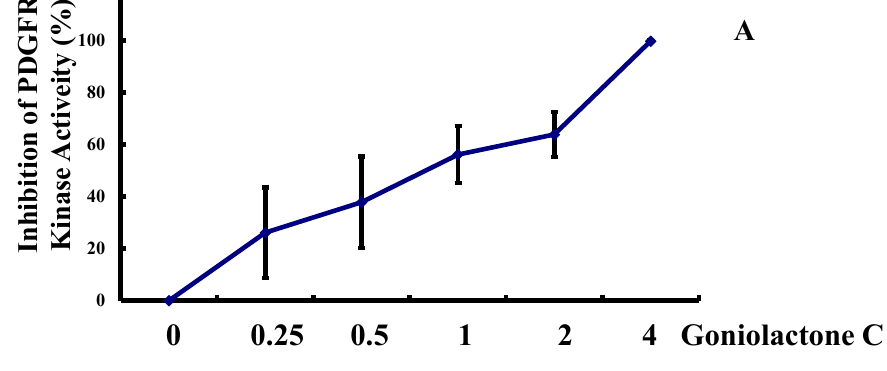
Figure 5. Goniolactone C inhibits the PDGFR-β/ERK1/2 cell signaling cascade. ( A ) A PDGFRβ Kinase Enzyme System assay (PDGFRβ Kinase Enzyme System V3731) was used to measure the in vitro activity of PDGFR-β. ( B , C ) Confluent VSMCs that had been starved for 24 h in FCS-free DMEM were treated with goniolactone C at different concentrations (0–4 μM) for 2 h and were then incubated in the presence of PDGF-BB for another 30 min. The cells were then lysed, and protein expression was analyzed using 12% SDS-PAGE. Western blot analyses were performed to detect the phosphorylation of PDGFR-β (B) and ERK1/2